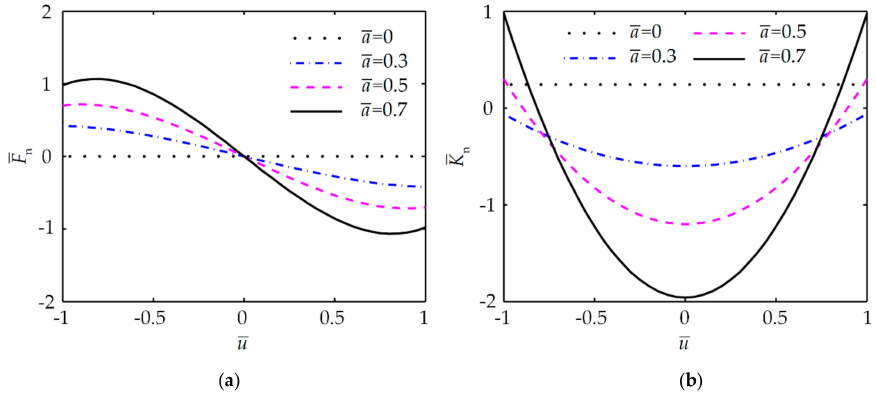
Figure 5. Non-dimensional characteristics of QCRM with δ n = 0.7. ( a ) Force-displacement curves; ( b ) sti ff ness curves.